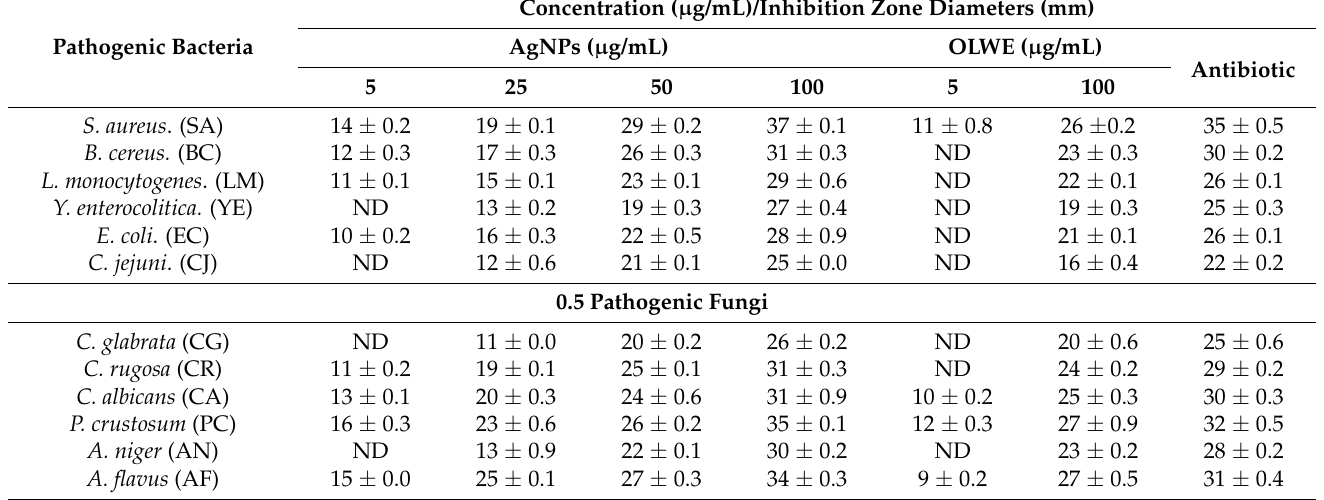
Table 2. Inhibition zone diameters (mm) of AgNPs, OLWE, and antibiotics against MDR pathogenic bacteria and fungi causing various diseases.